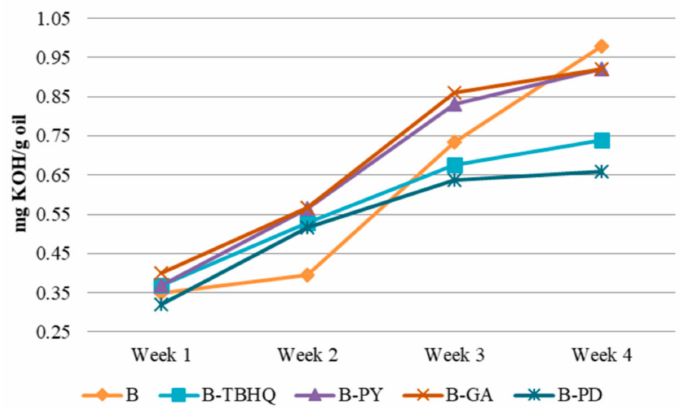
Figure 14. Acid number vs. biodiesel